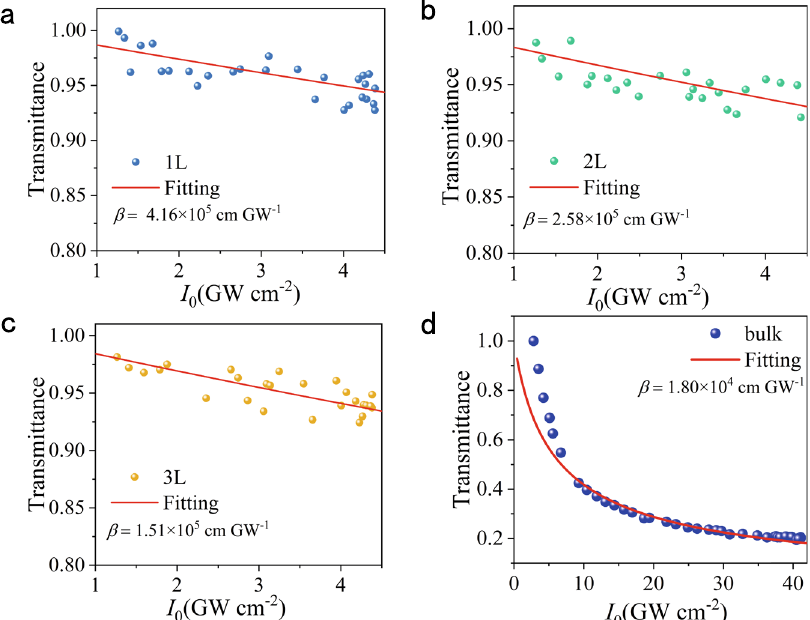
Fig. 5 TPA properties of 1 – 3 L and bulk PdSe 2 fl akes. a – c Nonlinear transmittance of 1 – 3 L PdSe 2 . The blue, green, and yellow dots represent the experimental data, while the solid red lines show the fi tted results using the TPA model. The TPA coef fi cients ( β ) of 1, 2, and 3 L PdSe 2 are 4.16 × 10 5 , 2.58 × 10 5 , and 1.51 × 10 5 cm GW − 1 , respectively. d Nonlinear transmittance of bulk PdSe 2 . The blue dots represent the experimental results, while the solid red lines show the fi tted results using the TPA model. The TPA coef fi cient ( β ) of bulk PdSe 2 is 1.80 × 10 4 cm GW − 1 . All the above measurements were performed under 800 nm